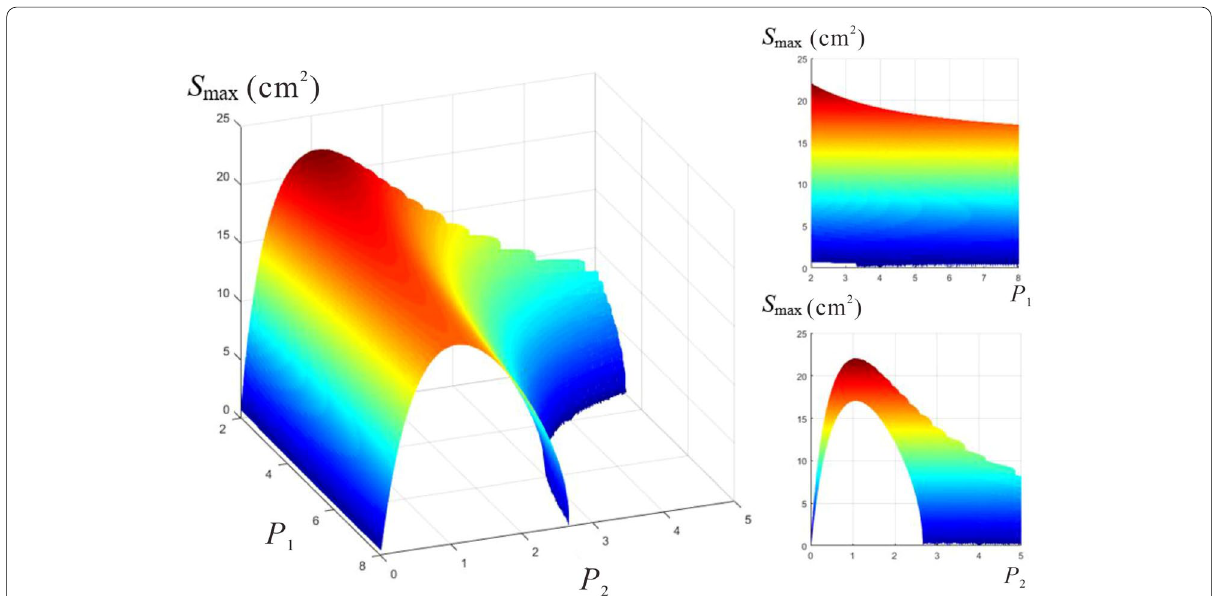
Figure 7 Results of the S max of the symmetrical palm workspace